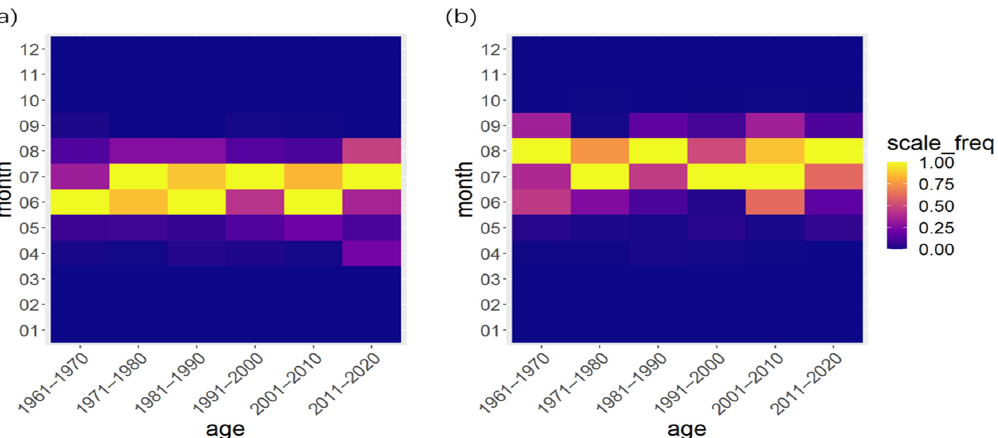
Figure 6. The distribution diagram of the earliest occurrence date and the latest extinction date of heat waves based on the absolute method. ( a ) Shows the distribution of the earliest occurrence date of heat waves in each month for each decade, and ( b ) Dhows the distribution of the latest extinction date of heat waves in each month for each decade.